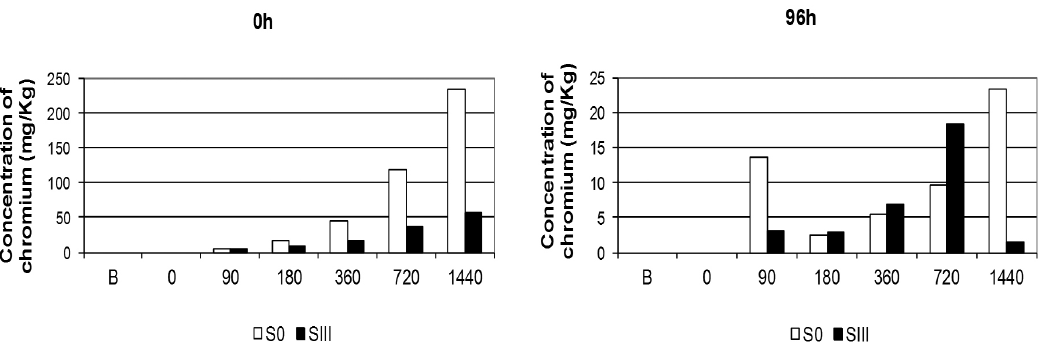
Figure 3. Chromium concentration in the sediment at the beginning (0h) and end (96h) of the tests with artificial sediment in Chironomus xanthus with (SIII) and without organic matter (S0). B: control (treatment with sand without contamination by chromium).